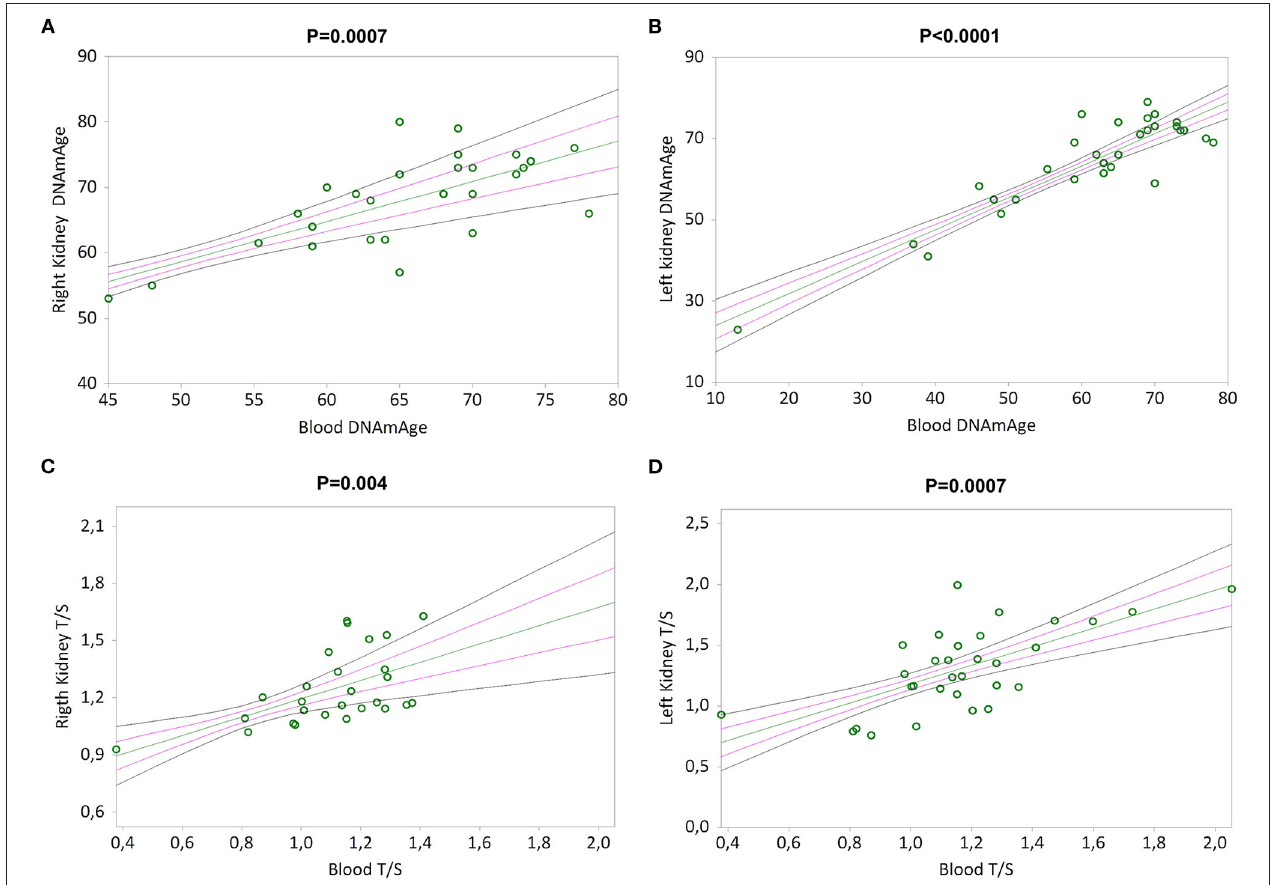
FIGURE 5 | DNAmAge and TL in both kidneys (right and left) correlation with blood leukocytes. In (A) and (B) , non-parametric linear regression plots showing the correlation between DNAmAge of the right kidney (RK) and the left kidney (LK), and blood DNAmAge (Kendall’s rank correlation coefficient tau b for RK = 0.479 and tau b for LK = 0.540). In (C) and (D) , non-parametric linear regression plots showing the correlation between TL of the right kidney (RK) and the left kidney (LK), and blood TL (Kendall’s rank correlation coefficient tau b for RK = 0.396 and tau b for LK = 0.432). Mean, Standard Error (SE) and 95% coefficient intervals (CI) are represented as green, pink and black lines,